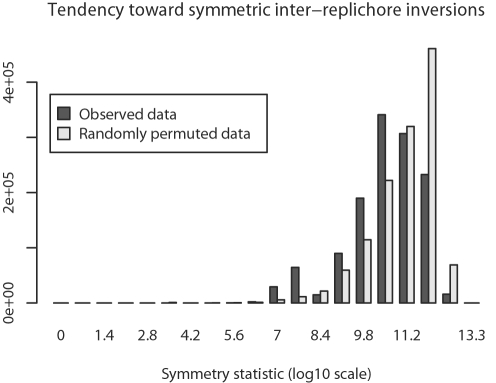
Inter-replichore inversions exhibit symmetry.Inter-replichore inversions exhibit greater symmetry about the origin and terminus than expected under a null model. Symmetry for inter-replichore inversions has been quantified by Equation 1 and compared to a null distribution. The null distribution is created by applying the permutation statistic in Eqn 2 to each of the 30,000 sampled rearrangement histories. The pooled posterior samples and permutations are plotted here, statistical tests are done on a per sample basis.